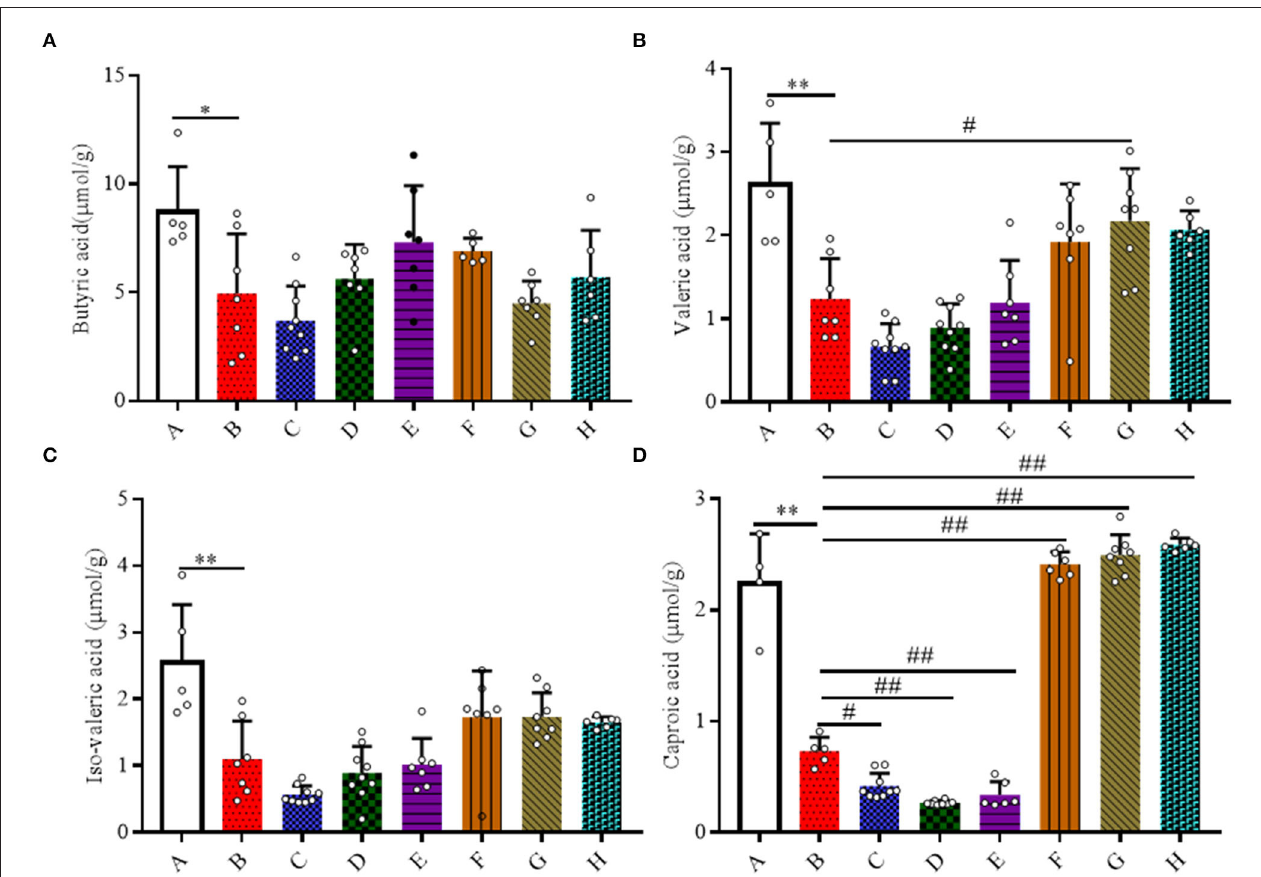
FIGURE 6 | Effect of SFN on volatile fatty acids concentrations in colitis mice. The samples were collected from colonic contents of all groups of mice. (A) Butyric acid; (B) Valeric acid; (C) Iso-valeric acid; (D) Caproic acid. All data are presented as the mean ± SD. P- value < 0.05 was considered to indicate statistical significance (* P < 0.05 and ** P < 0.01 compared with Group A, # P < 0.05 and ## P < 0.01 compared with Group